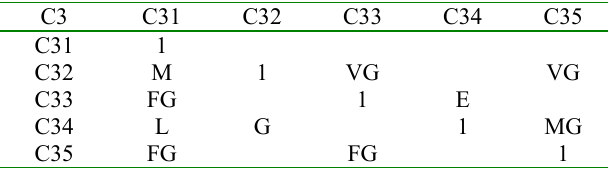
Table 12. Linguistic evaluation matrix of DM2 for C3